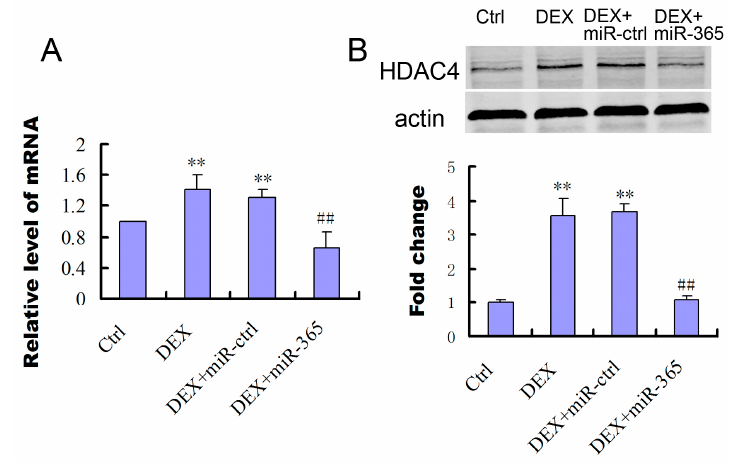
Figure 4. MiR-365 over-expression inhibited DEX stimulation of histone deacetylase 4 (HDAC4) expression. ( A ) mRNA expression of HDAC4 in MC3T3-E1 cells after transfection of miR-365 mimic or negative control ( n = 3); ( B ) Western blot analyzed the protein expression of HDAC4 in MC3T3-E1 cells after treatment with miR-365 mimic or negative control for 48 h ( n = 3). ** p < 0.01 compared to control, ## p < 0.01 compared to DEX+miR-ctrl.